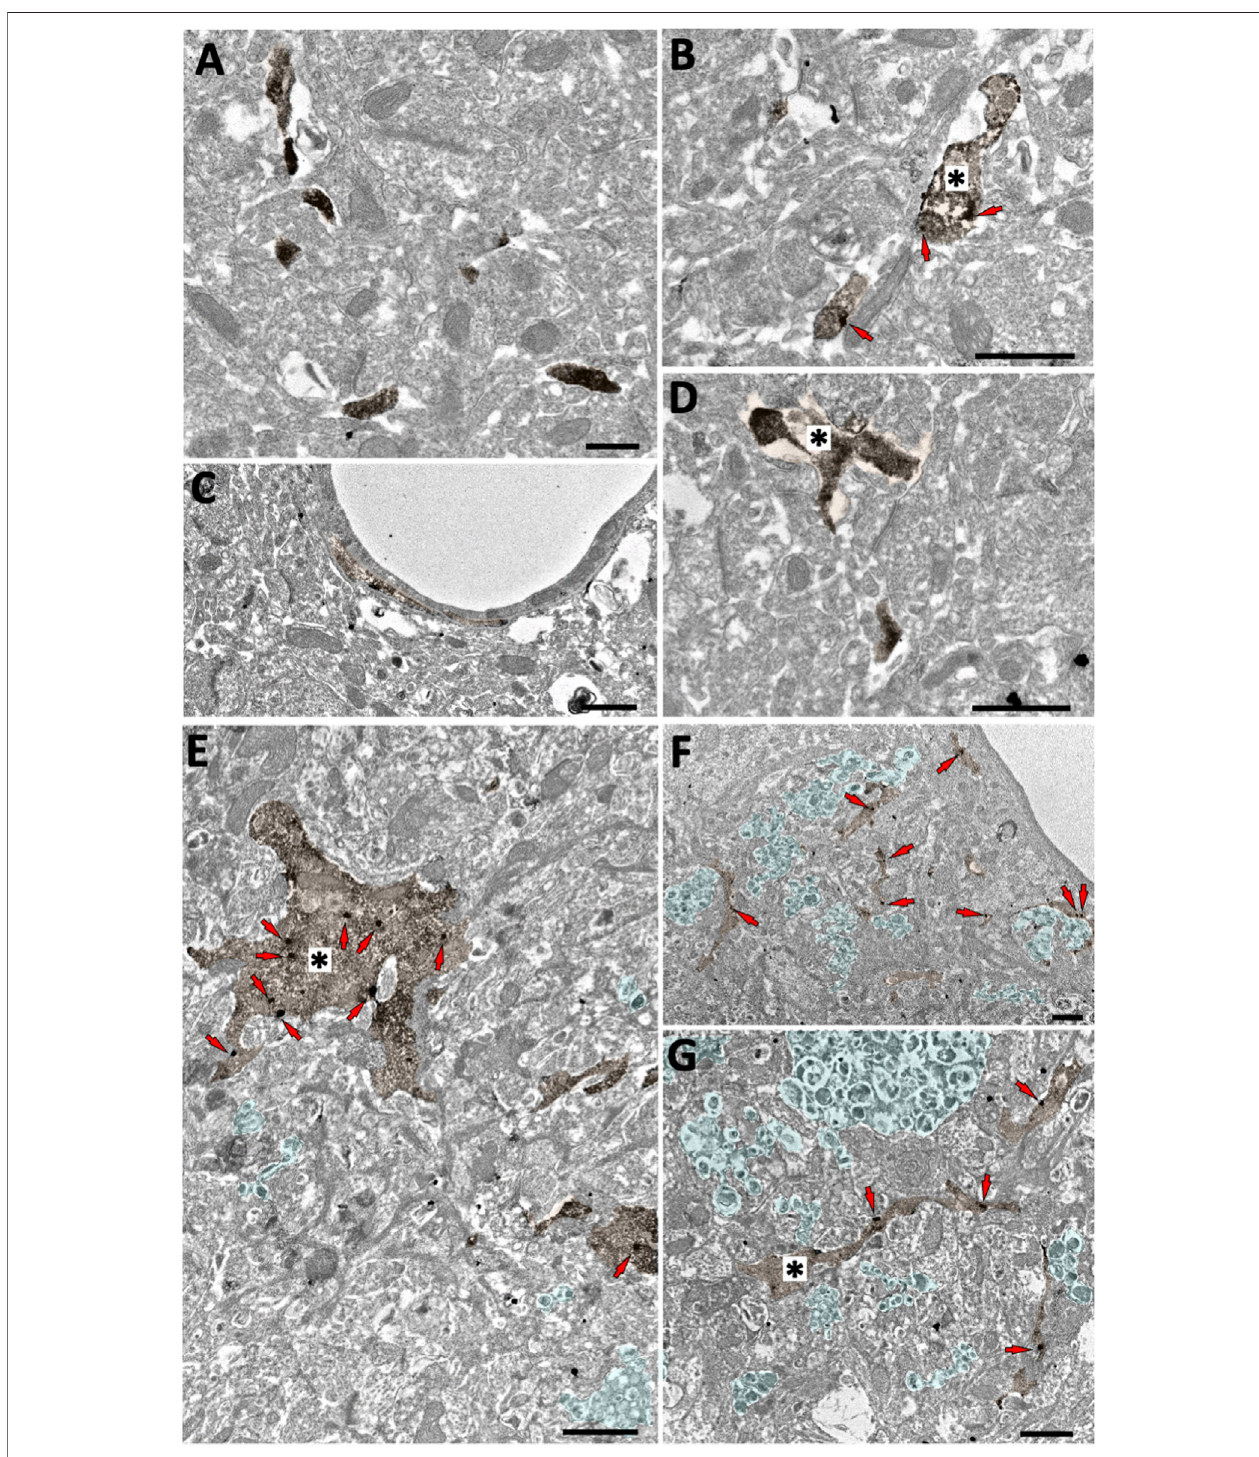
FIGURE 1 | Microglial GFP localization in the subiculum of CB 2EGFP/f/f and 5xFAD/CB 2EGFP/f/f mice. Double pre-embedding immunogold (GFP) and immunoperoxidase (Iba1) method for electron microscopy. GFP particles (red arrows) localize in Iba1-positive microglial elements (DAB immunodeposits, brown, *). In CB 2EGFP/f/f (A – D) ,onlyGFPmembranelocalizationisobserved(arrows, (B) .In5xFAD/CB 2EGFP/f/f ,GFPparticlesarefoundinbothmembranesandcytosol (E – G) .Notice dystrophic neurites (light green areas contoured by white dashed lines) in 5xFAD/CB 2EGFP/f/f . Scale bars: 1 µm.